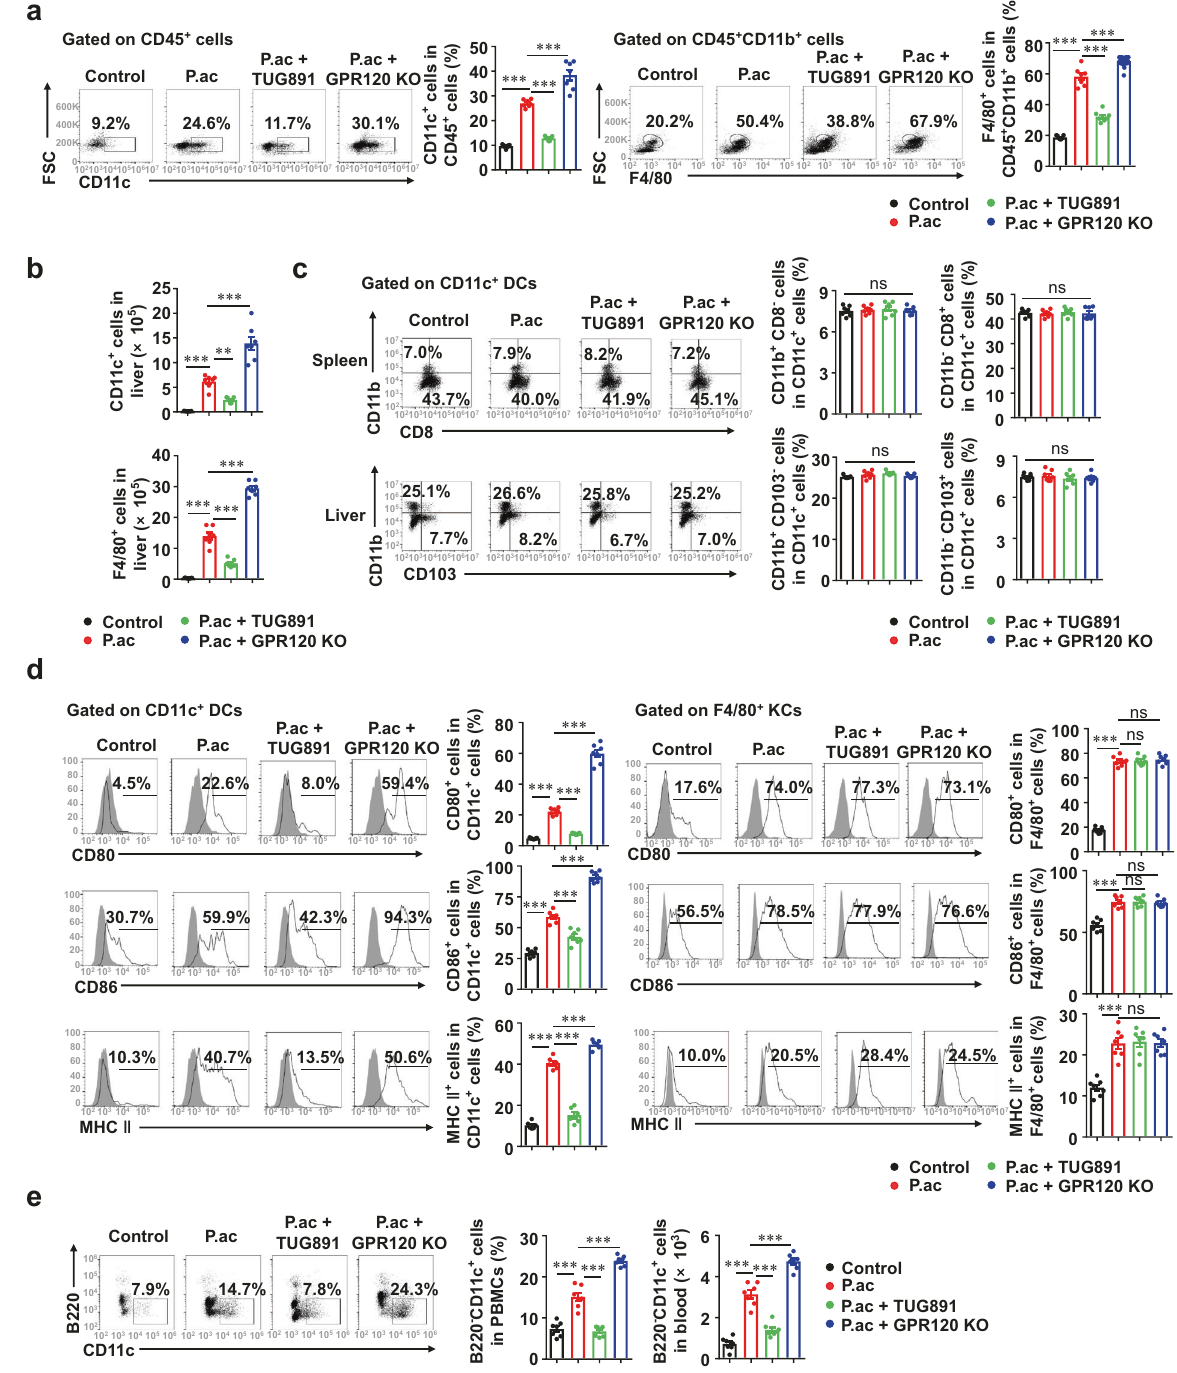
Fig. 4 GPR120 regulated the activation and maturation of DCs, but had no effects on macrophage activation. Wild-type (WT) and GPR120 − / − (GPR120 KO) mice were injected with P. acnes (P.ac). Vehicle or TUG891 (10 mg/kg) was administered i.p. to WT mice on days 0, 2, 4, and 6 after P. acnes injection. Livers and peripheral blood were isolated from the mice ( n = 7 mice per group). a Percentages of CD11c + DCs in liver CD45 + cells and F4/80 + KCs in liver CD45 + CD11b + cells were analyzed by fl ow cytometry. b Absolute numbers of CD11c + DCs and F4/ 80 + KCs in liver MNCs were analyzed by fl ow cytometry. c The percentages of splenic and liver DCs (CD11b and CD8 in the spleen) and (CD103 and CD11b in the liver) were analyzed by fl ow cytometry. d Levels of CD80, CD86, and MHC II on F4/80 + KCs and CD11c + DCs in livers were analyzed by fl ow cytometry. e The percentages and numbers of CD11c + B220 − DC precursors in the peripheral blood MNCs from each group were analyzed by fl ow cytometry. The results are representative of three independent experiments and presented as the mean ± SEM. Signi fi cant differences were analyzed by One-way ANOVA. ** p < 0.01, *** p < 0.001, ns no signi fi cance.